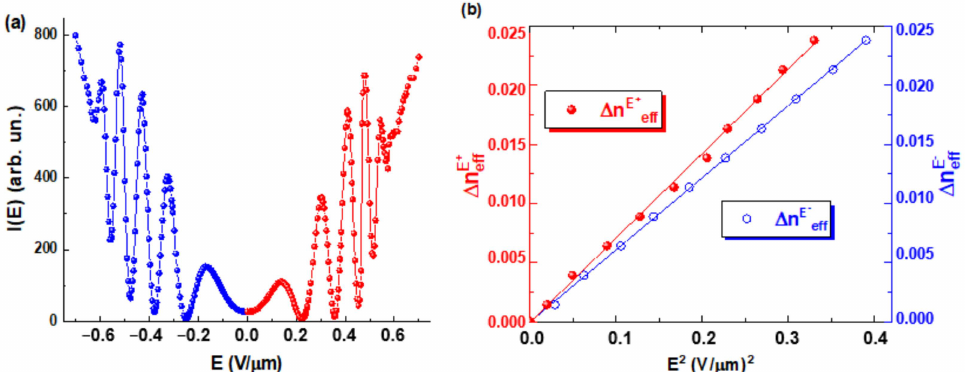
Figure 5. ( a ) measured intensity I ( E ) of monochromatic light ( λ = 532 nm) transmitted through the DHFLC cell ( d = 107 µ m) placed between crossed polarizers at β = 0. Ferroelectric liquid crystal FLC-618 described in [34] was used in experiments carried out and at 23 ◦ C, the applied electric field frequency 7 Hz; ( b ) the effective birefringence ∆ n E + and ∆ n E − of the FLC-618 versus square of the eff eff applied electric field for its both polarities: ∆ n E + ( red balls ) was measured for the positive polarity, eff while ∆ n E − ( blue circles ) for the negative eff